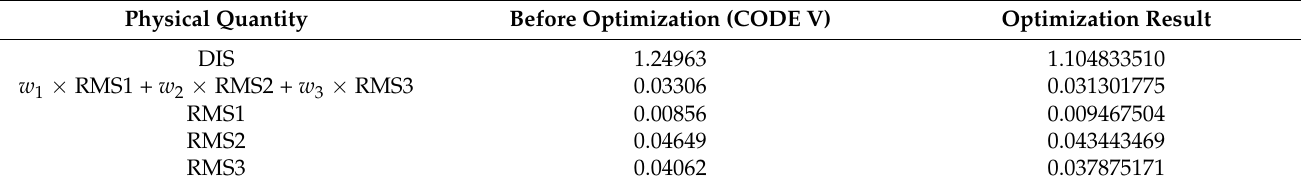
Table 4. Comparison of results before and after optimization.